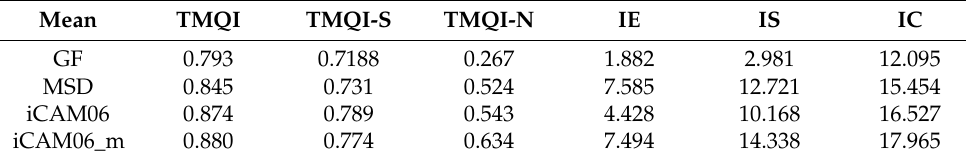
Table 1. Objective evaluation results of image a .